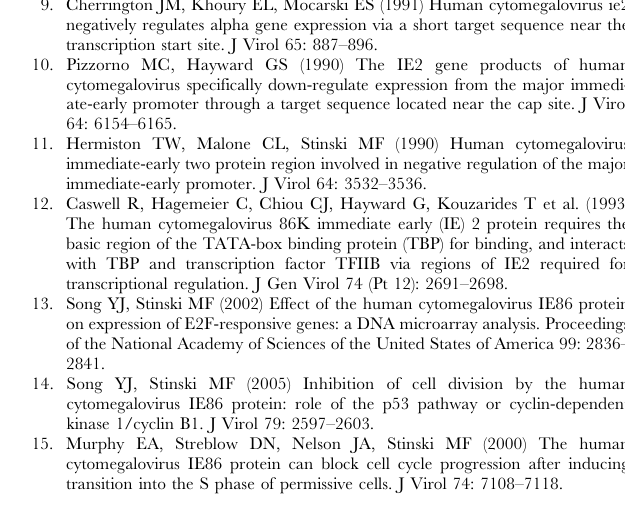
Figure S1 Western blotting of TAP samples. Samples collected from tandem affinity purification procedure of HFF cells infected